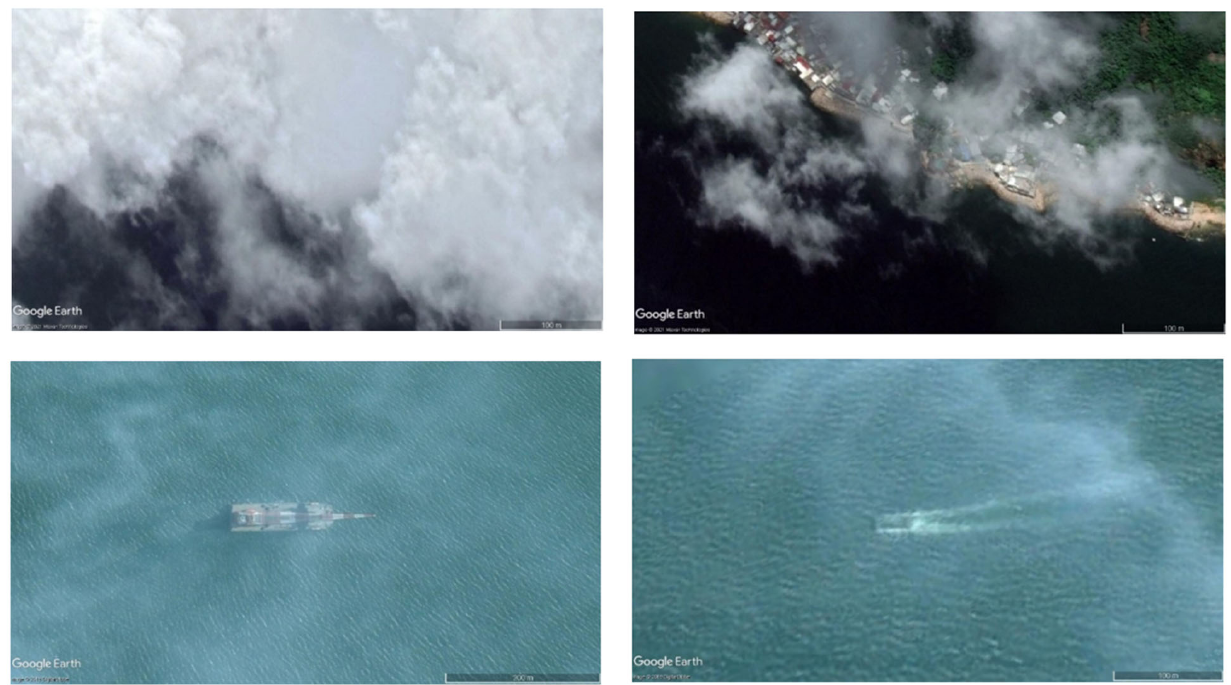
Figure A2. The example images from VHRShips with cloud and haze noise.